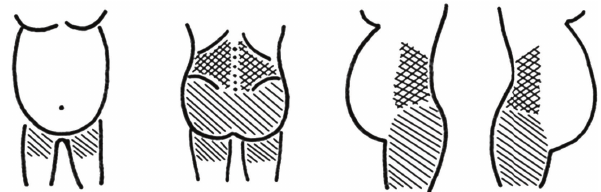
Figure 1: The pain diagram for self-report of LBP and/or PGP.